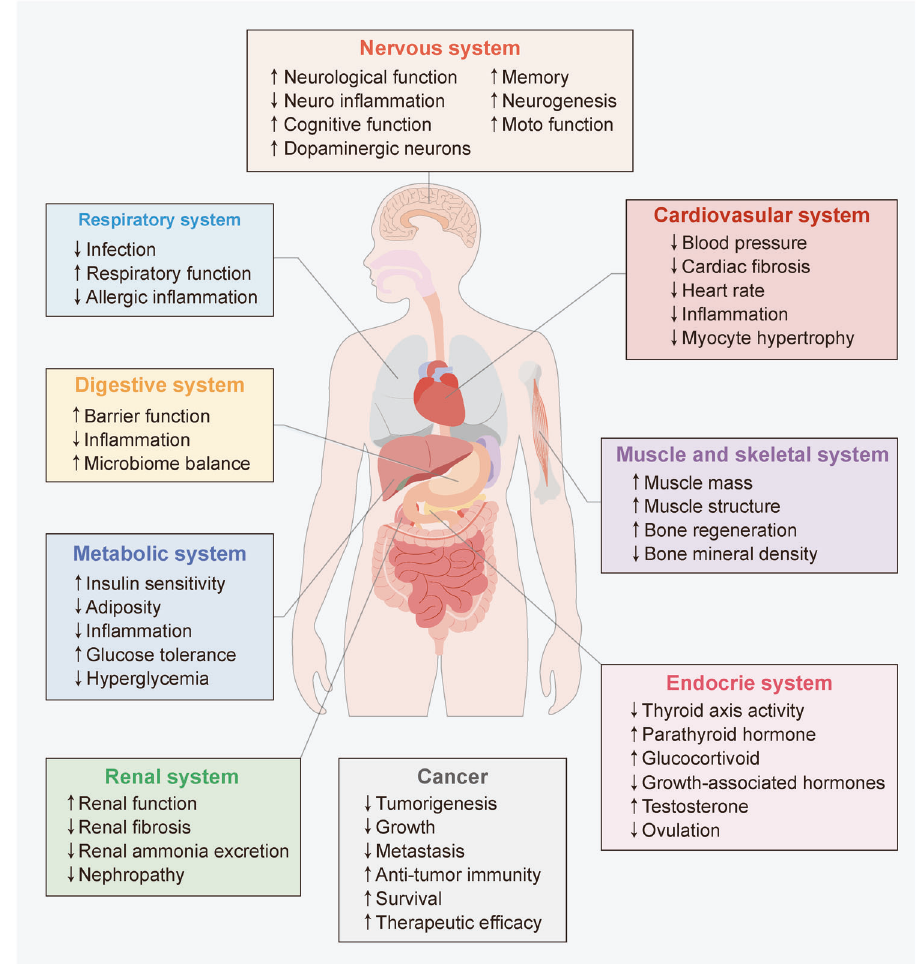
Fig. 3 Functionality of dietary interventions on human tissues under health and diverse disease states. Dietary interventions exert bene fi cial effects across varying aspects, including nervous system, cardiovascular system, respiratory system, metabolic system, renal system, endocrine system, and digestive system as well as